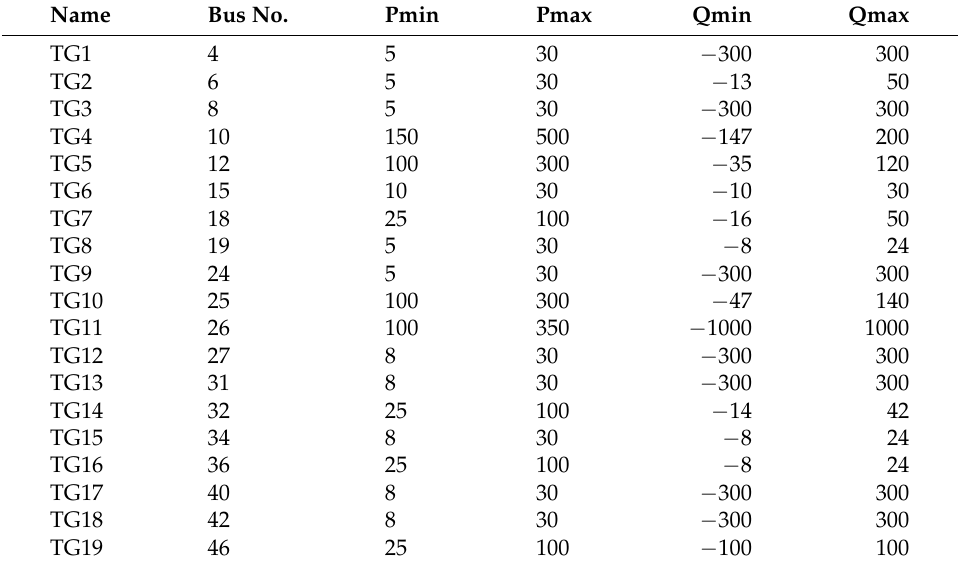
Table A1. IEEE 118 bar system generation